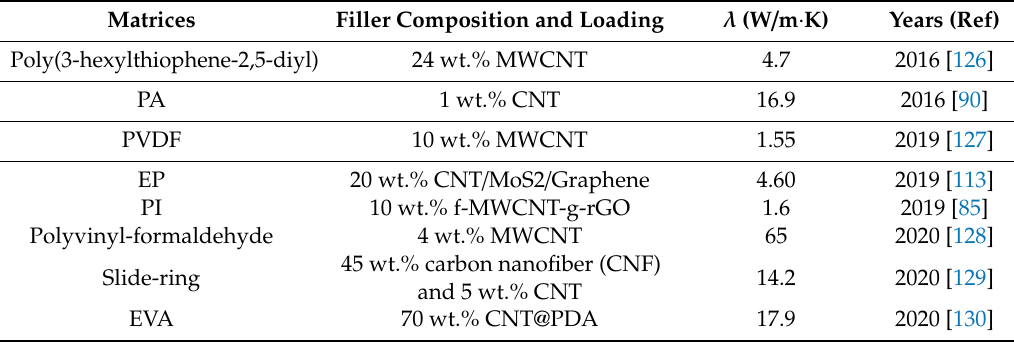
Table 3. λ of carbon nanotube / polymer